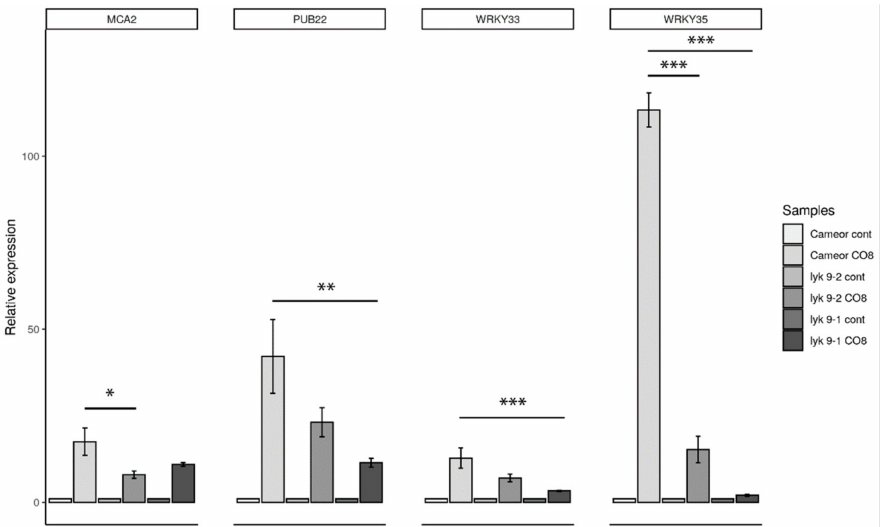
Figure 3. Transcript levels of MCA2, PUB22, WRKY33 and WRKY35 defense response genes in pea roots treated with 10 − 5 M CO8-DA for 24 h. As a control, medium-treated plants were used. Relative expression was normalized against constitutively expressed ubiquitin and actin genes. For each gene, the transcript level in non-inoculated roots of wild-type or mutants was set to 1 (control), and that in treated roots was calculated relative to the control values. The graphs show the results of three independent experiments. The error bars represent SEM of three repeats. For one biological repeat, the fragments of non-inoculated main roots or nodules from 3–4 plants were collected and used to isolate RNA. The asterisks indicate statistically significant differences based on one-way analysis of variance (one-way ANOVA), followed by Tukey’s post-hoc test results. (* p < 0.05; ** p < 0.01, *** p <